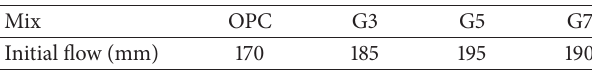
Table 3: Initial flow of the mortar mixes.